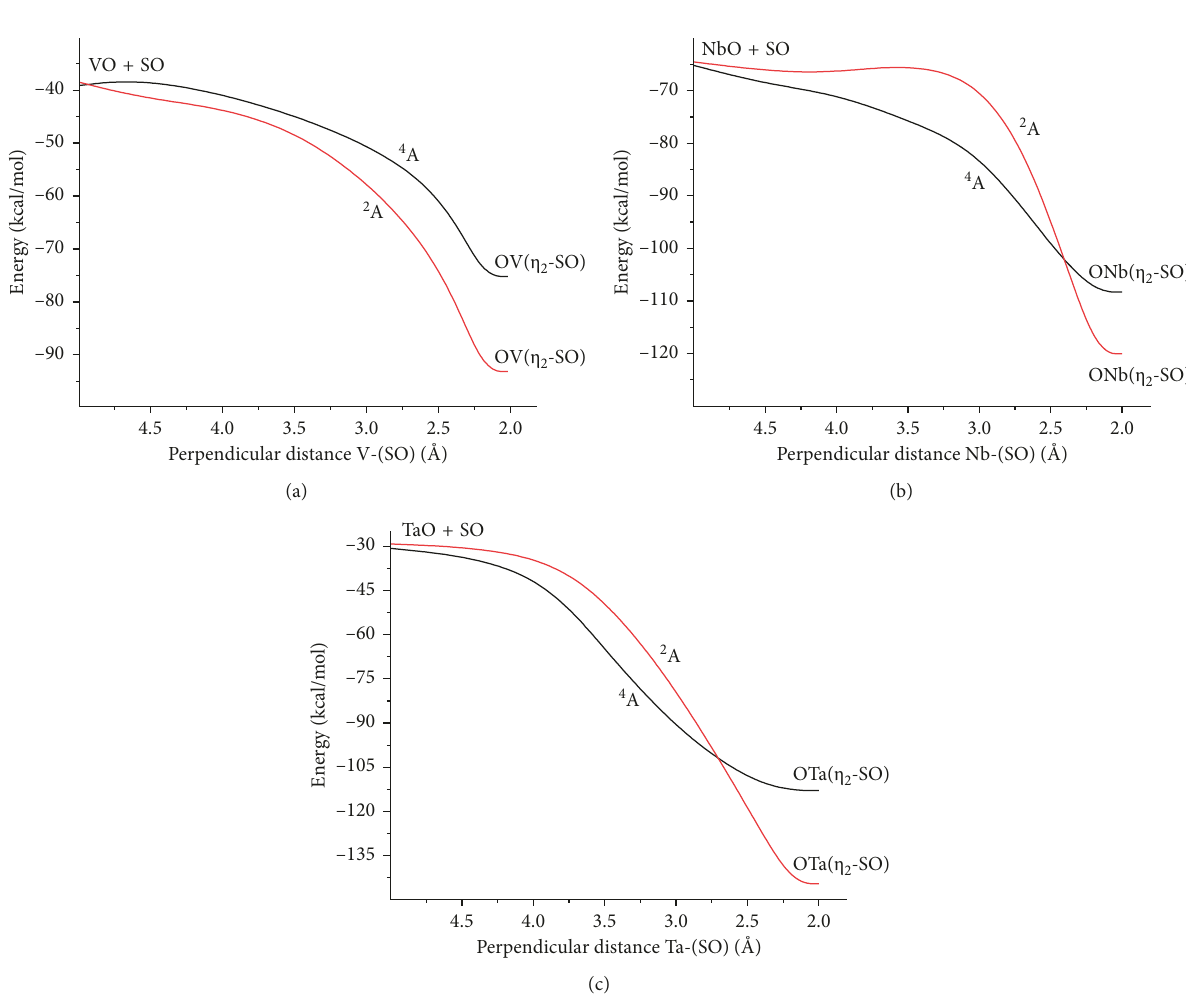
Figure 2: Energy plots for the recombination of the radical fragments MO+SO through the quadruplet and doublet electronic